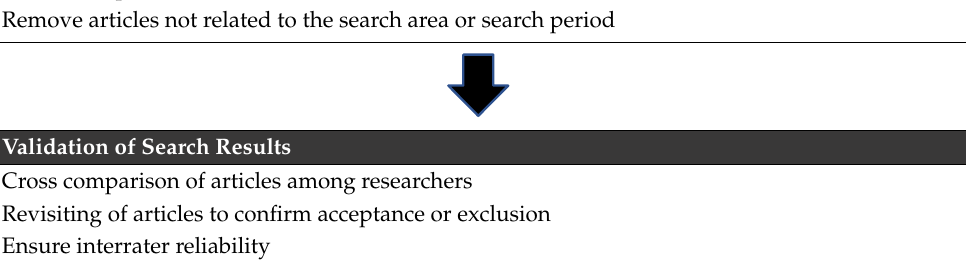
Table 4. Extent of Success of